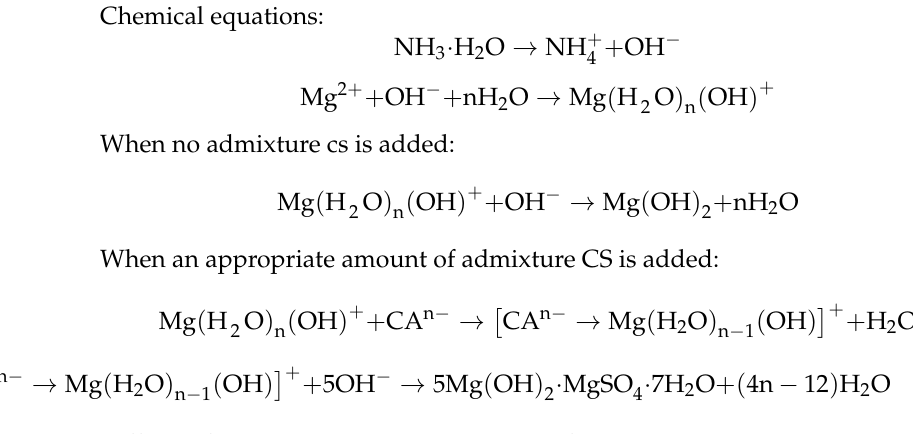
Figure 5. Schematic showing the formation mechanism of 517-type BMSW.